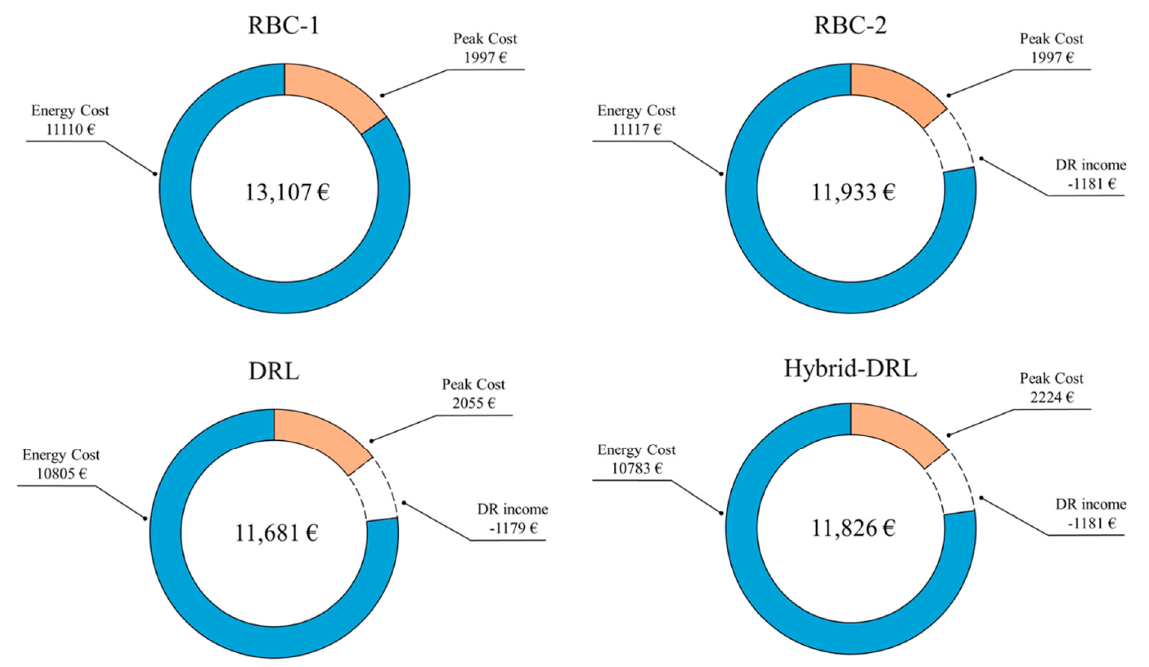
Figure 10. Cost disaggregation: a comparison between the different developed control strategies.